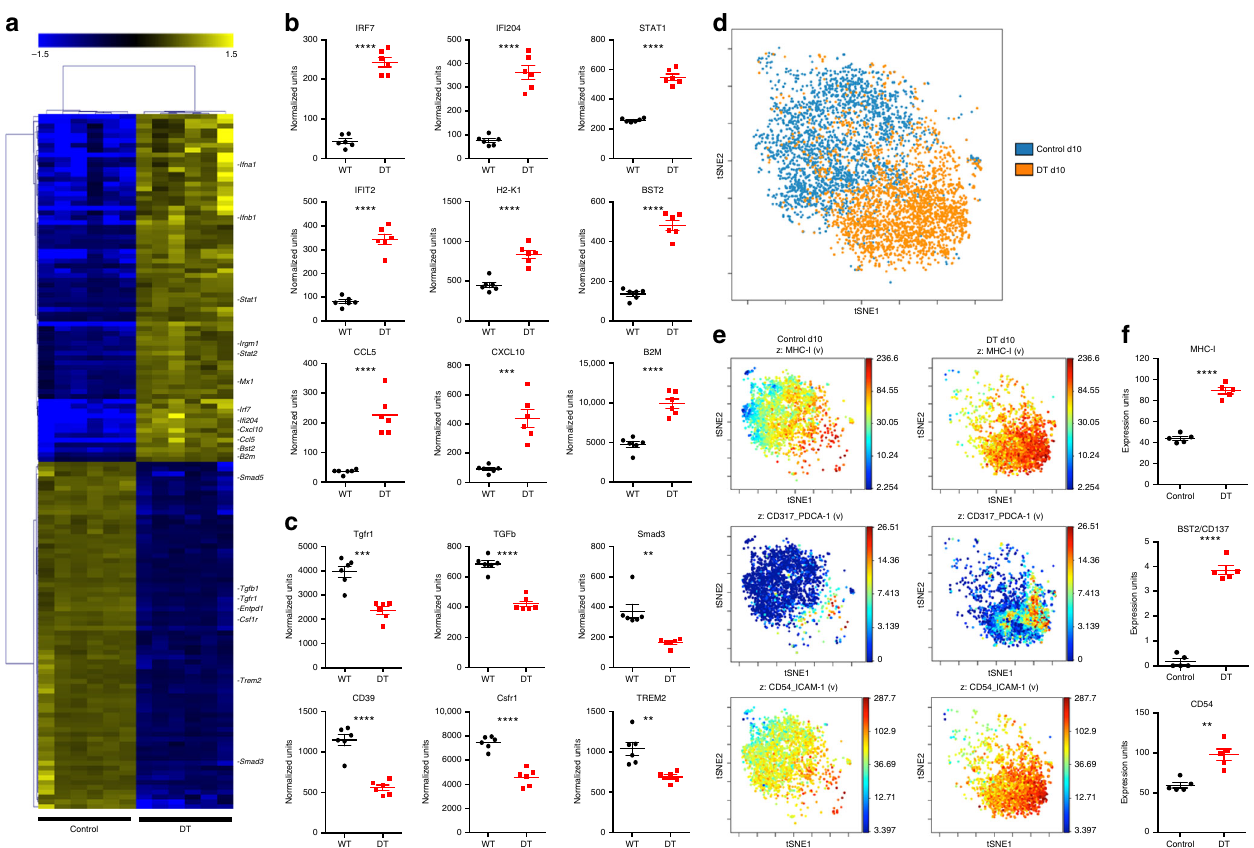
Fig. 4 Loss of homeostatic microglia after depletion. CD11b + CD45 int CX3CR1-GFP + Ly6C – microglia were sorted from d10 control and d10 post microglia depletion mice and their transcriptome was analyzed using the Nanostring mouse immunology kit. a Heatmap depicts hierarchical clustering of signi fi cantly upregulated (yellow) and downregulated (blue) genes in microglia from six control and six d10 microglia-depleted mice. b , c Dot plots demonstrate the relative expression levels in wild-type control (black bars) and d10 post depletion microglia (red bars). b Microglia from ataxic mice demonstrated upregulation of type 1 interferon pathway genes: IRF7, I fi 204, Stat2, I fi t2, H2-K1, B2M, BST2, CCL5, CXCL10 . c Microglia from ataxic mice demonstrated lower expression of genes associated with a homeostatic microglia signature TGFb , Tgfr1 , Smad3, CD39 (Entpd1), Csfr1 and Trem2 . To assess the activation state of repopulated microglia, control and d10 post depletion CX3CR1-GFP + CD45 int CD11b + Ly6C – microglia were analyzed by CyTOF. d ViSNE analysis of control and repopulated microglia demonstrated that repopulated microglia cluster differently than controls, indicating a unique activation state of these cells. e Expression of MHCI, CD137/BST2 and CD54 in control and repopulated microglia clusters. f Dot plots depict quanti fi cation of CyTOF expression units for MHCI, CD137/BST2 and CD54 in control (black) and d10 post depletion microglia (red). Representative experiment of two independent experiments. Error bars depict SEM and n = 5 – 7 mice per group. Analyzed with Student ’ s unpaired t -test at 95% con fi dence interval and **** p < 0.0001, *** p < 0.001, ** p <